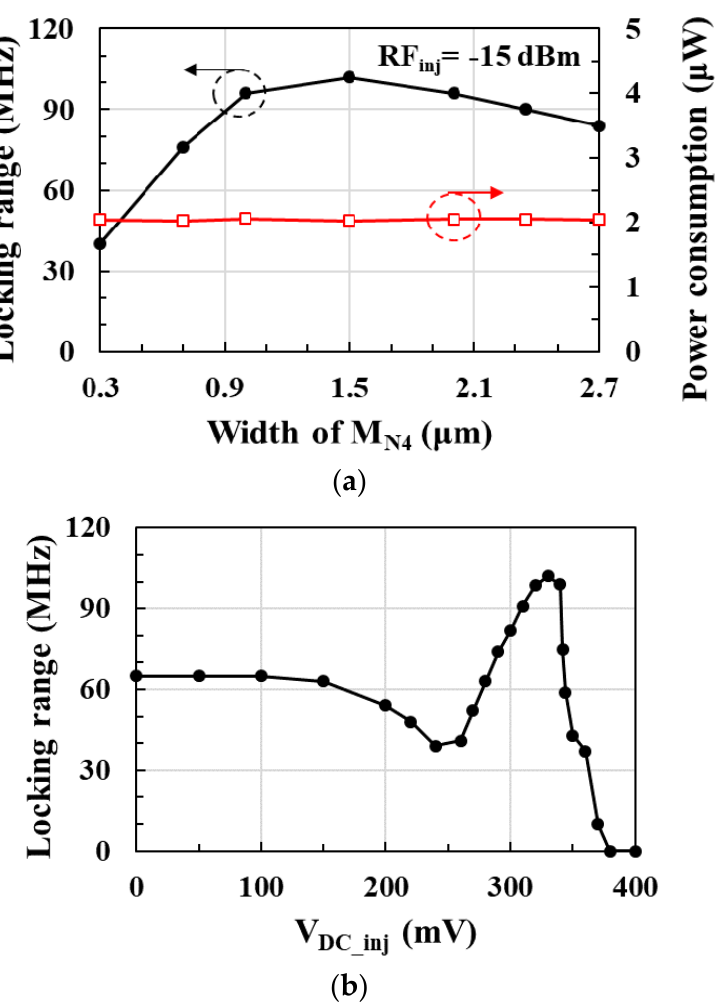
Figure 3. Locking range and power consumption of the RF clock harvester according to the ( a ) width and ( b ) gate bias voltage V DC_inj of injection transistor M N4 .